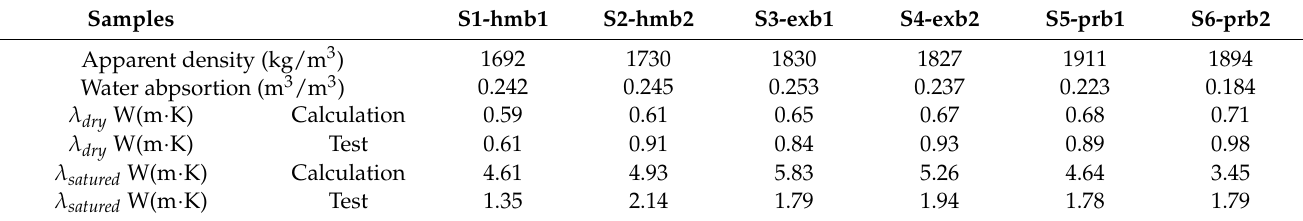
Table 8. Comparison of conductivity values in dry and saturated states for the samples studied by the applied